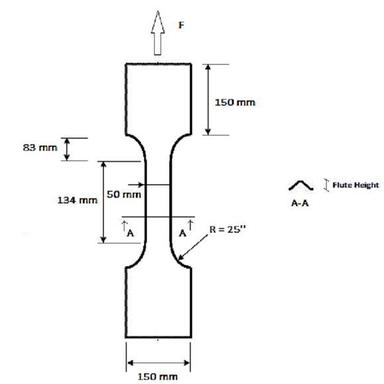
Longitudinal tensile test on corrugated board with sample dimensions.